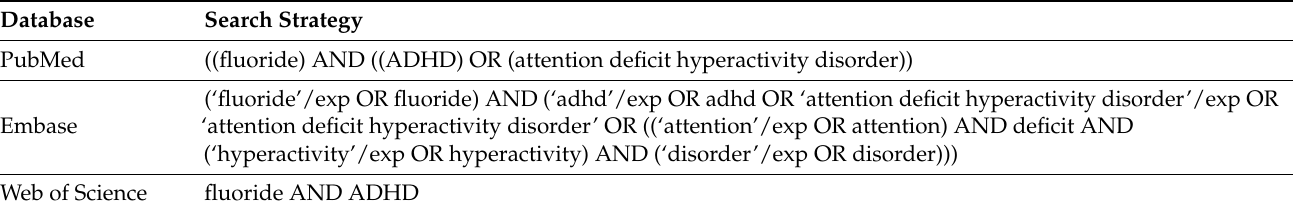
Table 1. Search strategies in online